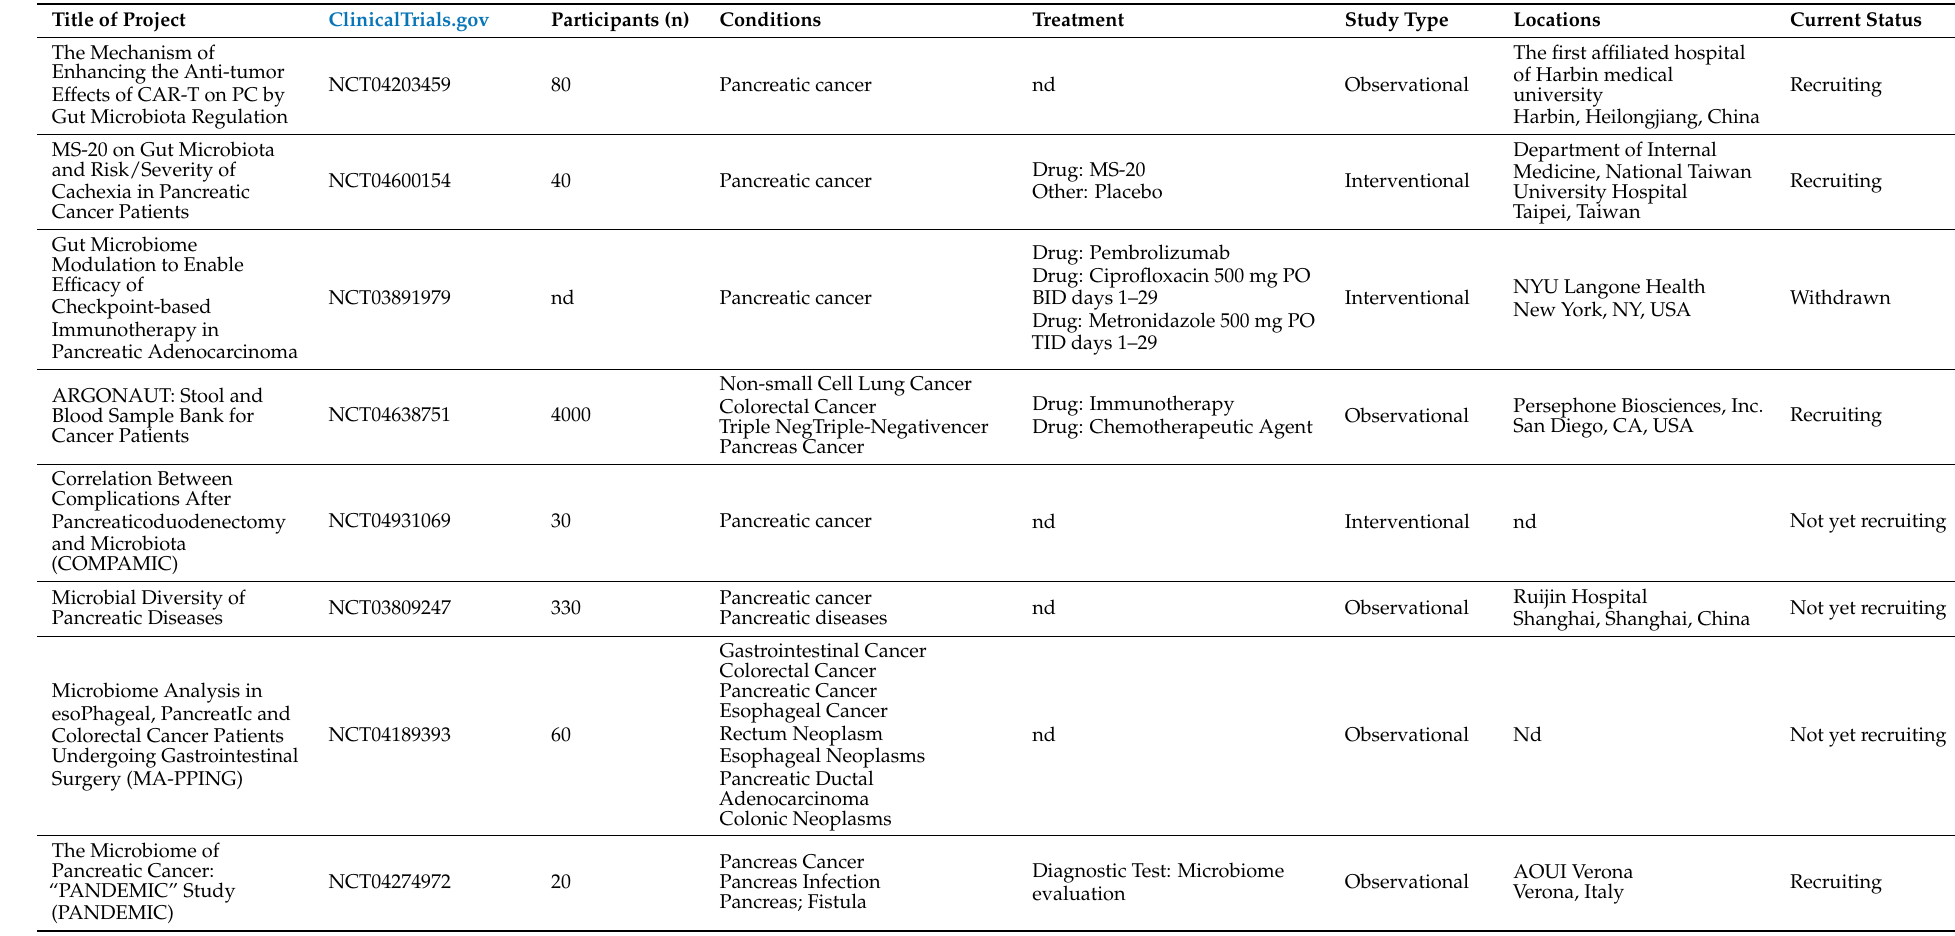
Table 1. The studies registered in the ClinicalTrials.gov system and regard pancreatic cancer and gut microbiome-associated